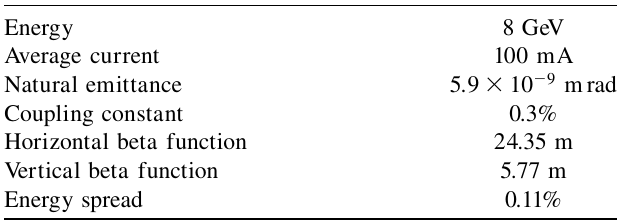
TABLE I. The electron beam parameters used in the calculations.